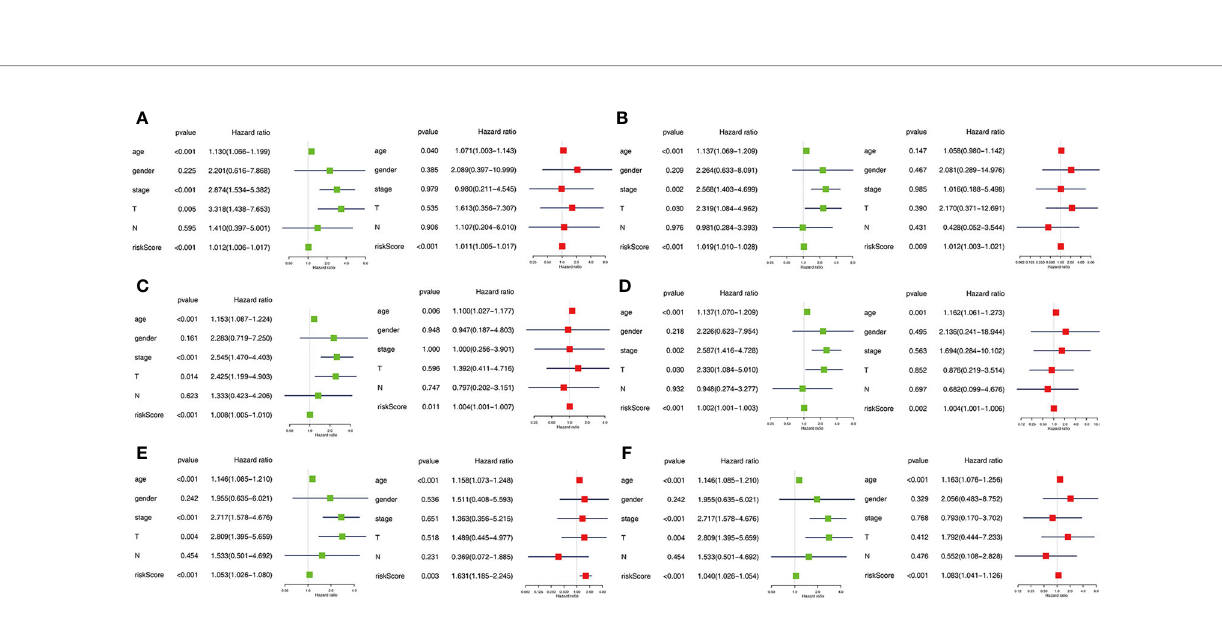
FIGURE 6 | Independent prognostic analysis determining predictors of overall survival. AA cohort (A) , AD cohort (B) , AT cohort (C) , ES cohort (D) , ME cohort (E) , the fi nal prediction cohort (F) . Forest plots showing the univariate (left) and multivariate cox regression analyses (right) of OS in